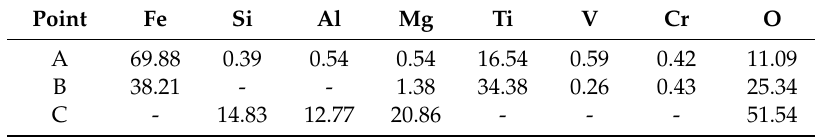
Figure 1. Micrographs of typical HCVTM particles.